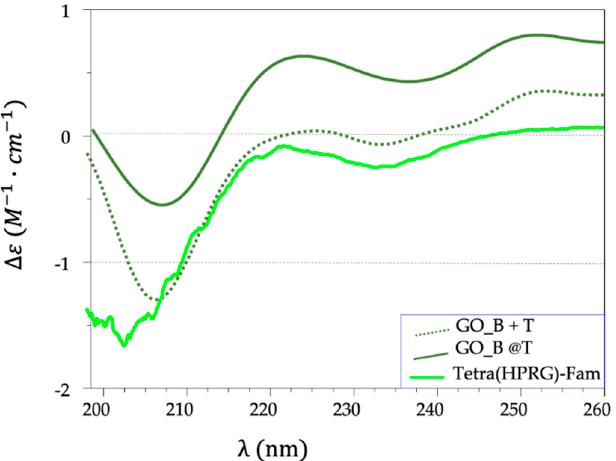
Figure 2. CD spectra in phosphate buffer saline solution (PBS, pH = 7.4) of Tetra(HPRG)-Fam (green, solid line, peptide concentration = 1 × 10 − 5 M) and the pellets (10 × dilution) for hybrid GO_B@T (dark green, solid line) and mixture GO_B + T (dark green, dotted line) samples.